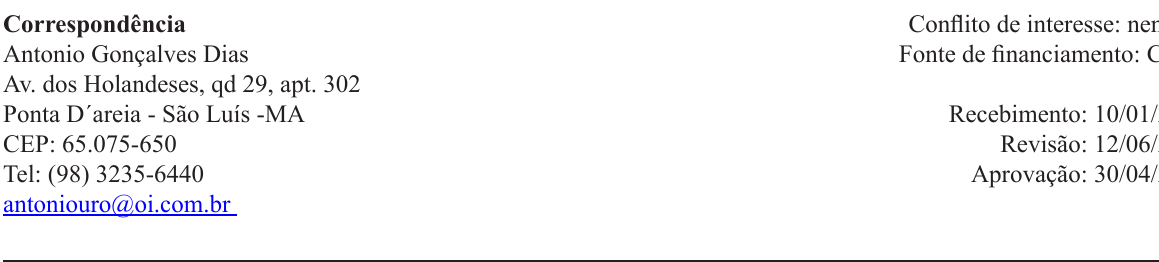
Figuras coloridas disponíveis em